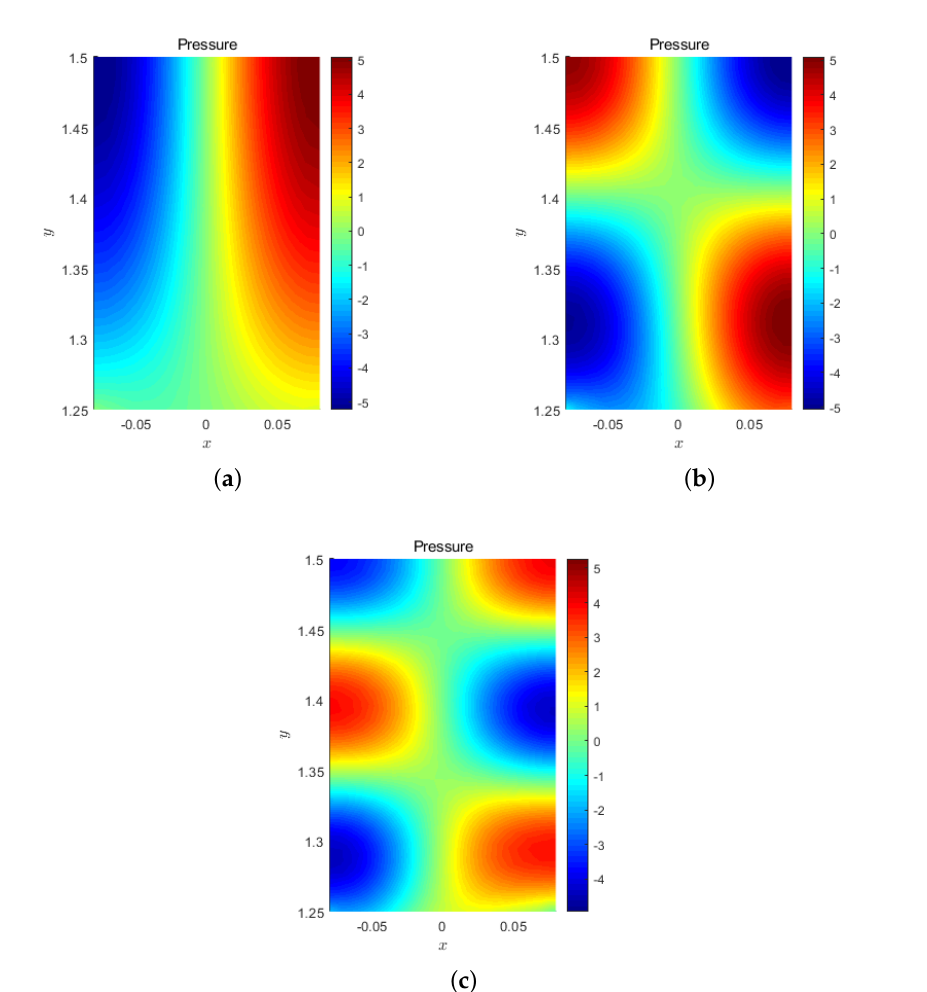
Figure 5. Resonances for the Neumann problem: ( a ) first trapped mode: f = 3.26; ( b ) second trapped mode: f = 4.08; ( c ) embedded trapped mode: f = 5.67 (only the pressure field in the cavity is